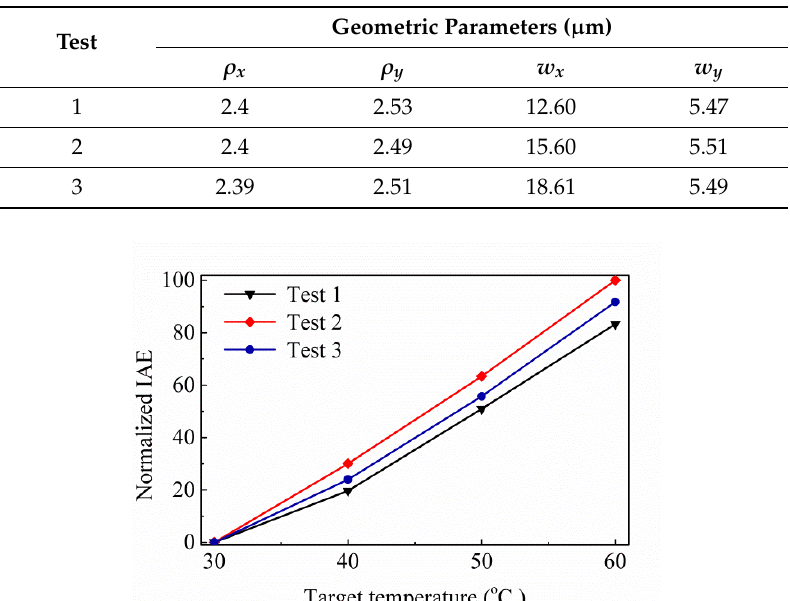
Figure 8. SA-SRHA SEM image of the CMOS compatible thermopile. Table 3. Measurement results for the geometric parameters of three proposed thermopiles.